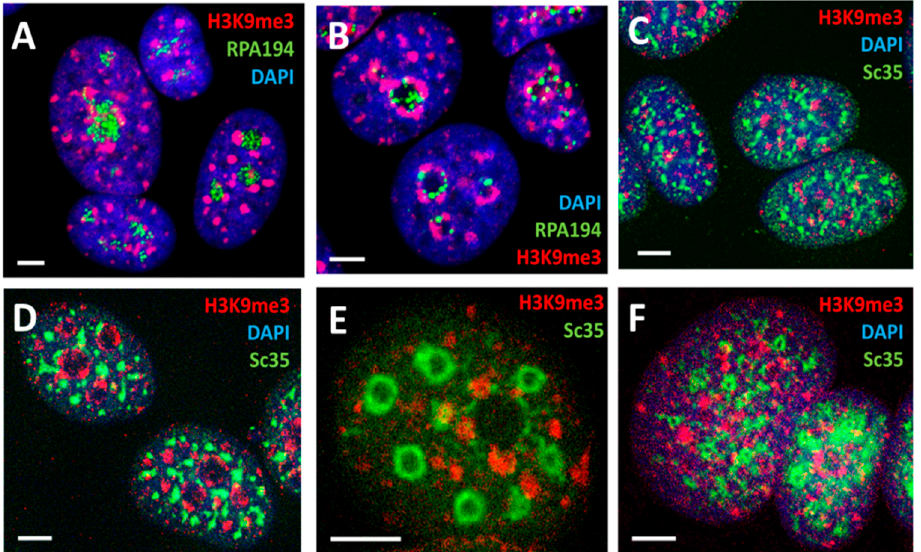
Figure 12. Partial inhibition of rRNA and mRNA synthesis by AcD and alpha-amanitin revealed the hidden radial-concentric spatial relationship between centers of nucleolar synthesis, perinucleolar PADs, and speckles; this order was destroyed after full suppression of transcription: ( A ) Con- trol: the granules of RPA1 fill the nucleoli, indicating active rRNA synthesis; ( B ) AcD 0.2 µ M/mL, 1 h—RPA1 form rare fused granules, indicating suppressed rRNA synthesis; H3K9me3 PADs compact and encircle the nucleoli; ( C ) control: elongated speckles and PADs seem disorderly distributed in the cell nucleus; ( D ) AcD 0.2 µ M/mL, 1 h—clumped speckles surround the compacted shells of perinucleolar PADs; ( E ) alpha-amanitin 2 µ M/mL for 2 h suppressing Pol II—an example of swollen empty speckles radially circumventing the deteriorating perinucleolar ring of PADs; ( F ) AcD 2 µ M/mL for 5 h suppressing both RNA syntheses with chaotically distributed disarranged PADs and empty speckles. Scale bars = 5 µ m. (Note: This figure was originally published under CC-BY license in [36].).